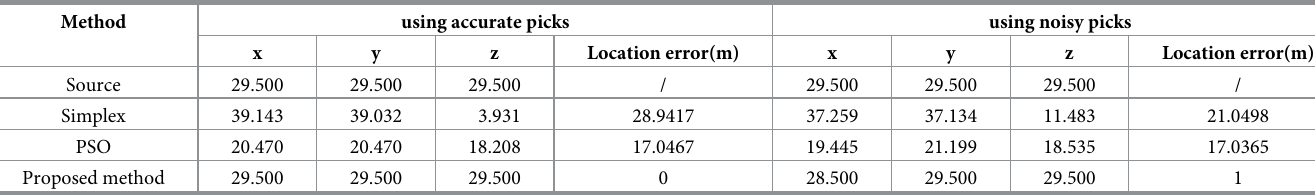
Table 2. Location results of the proposed method compared with Simplex and PSO in example I.